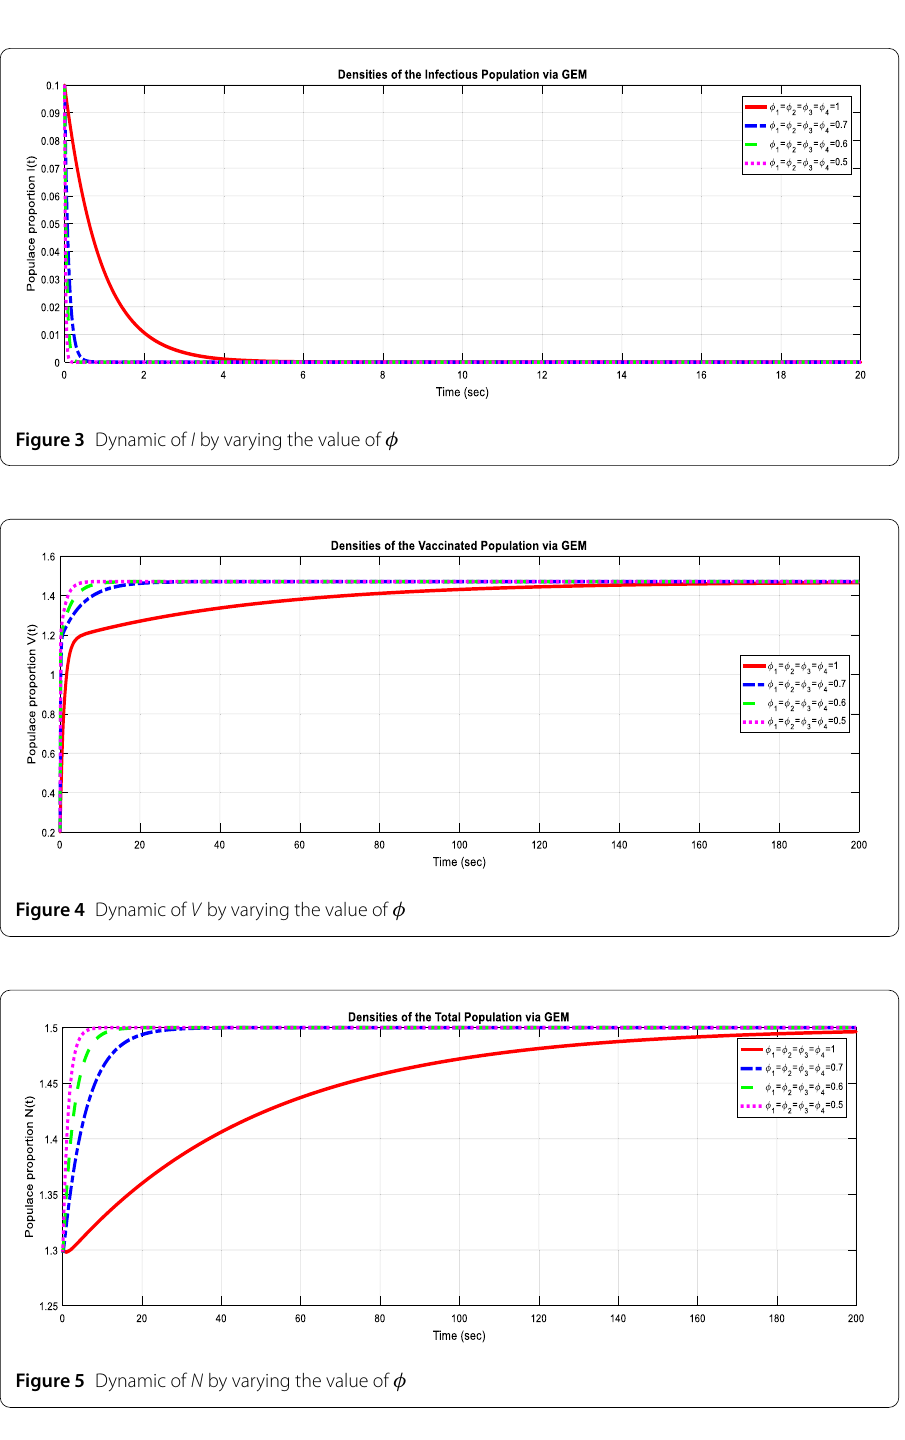
20, 21, 26, 28 and 31 depict that, for lower values of φ , the rampant peak is eclectic and less than the true equilibrium points. Figures 3, 5–6, 8–9, 12–14, 18–19, 27, 29–30, 32 and 33 illustrate that, for lower values of φ , the epidemic peak is eclectic and greater for true steady states. Also we find the length of time to approach equilibrium within a given tolerance. The early transient behaviors vary greatly among the methods. Numerical im- itations of an amended epidemic model with capricious order show that the